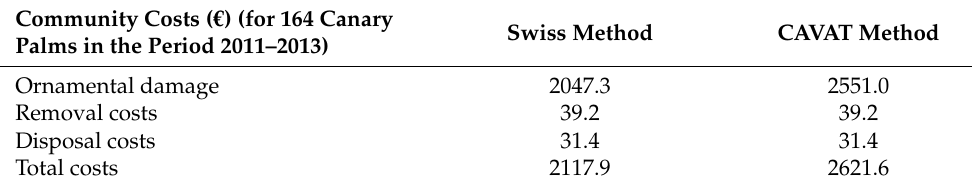
Table 3. Costs for the infections by RPW to Canary Palms in the City of Bari (in thousands of Euros). Community Costs ( € ) (for 164